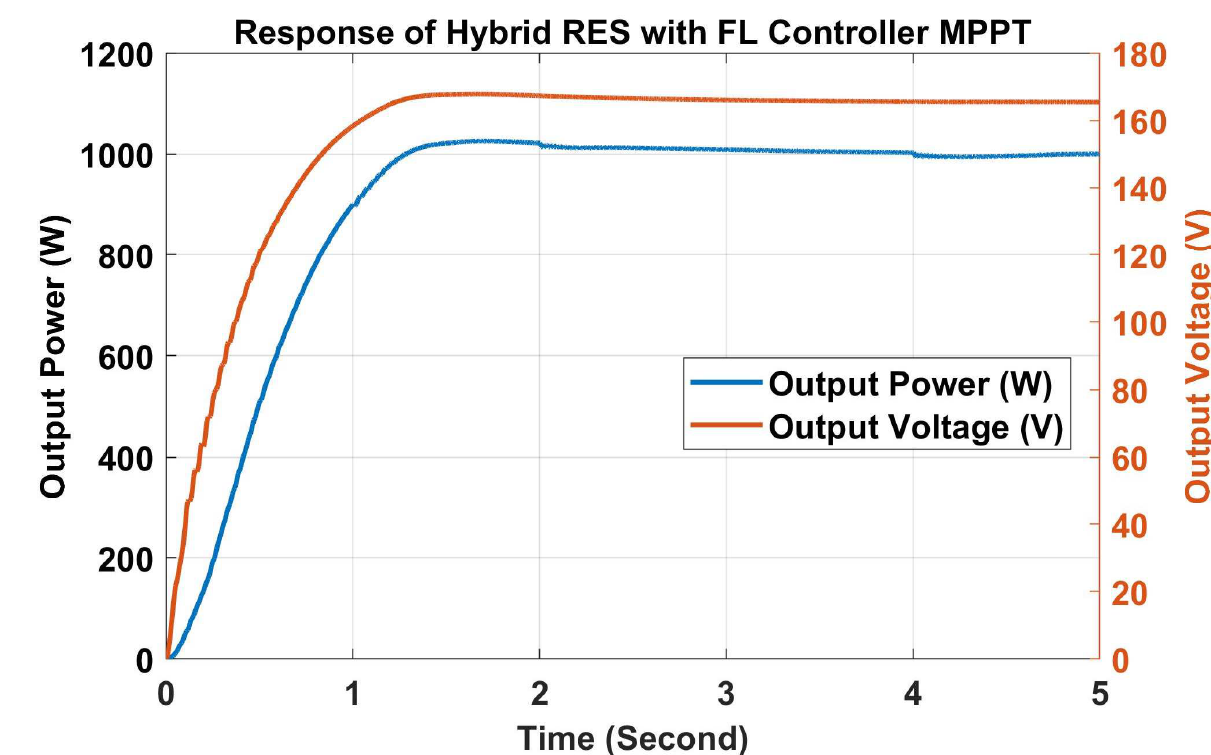
Figure 21. Output Power and Voltage of Hybrid RES with F-LC MPPT.